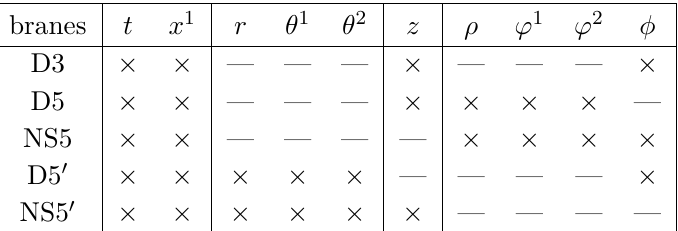
Table 1 . Brane picture underlying our D3-D5-NS5-D5 0 -NS5 0 brane intersection. The system describes a BPS / 8 D3-brane box